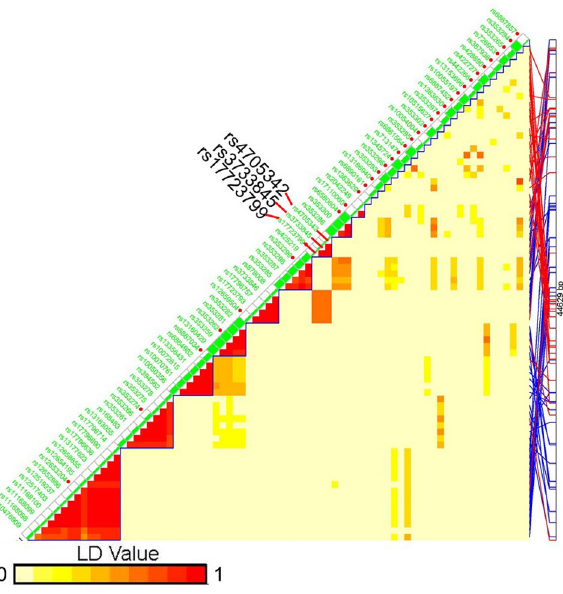
Figure 2. Haplotype block structure of miR-145 genomic region. Three SNPs surrounding rs4705342 are in high linkage disequilibrium (LD) and forms a small block. Rs3733845 was genotyped in GABRIEL study and serves as a tag SNP for